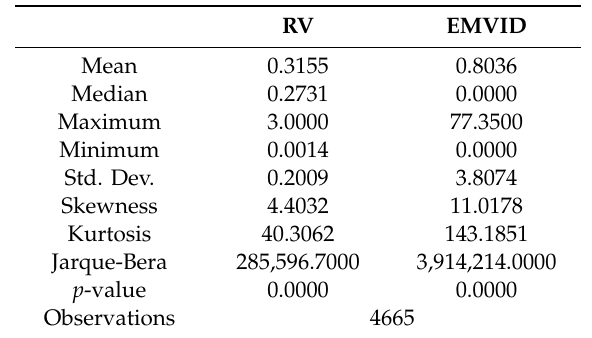
Table 1. Summary